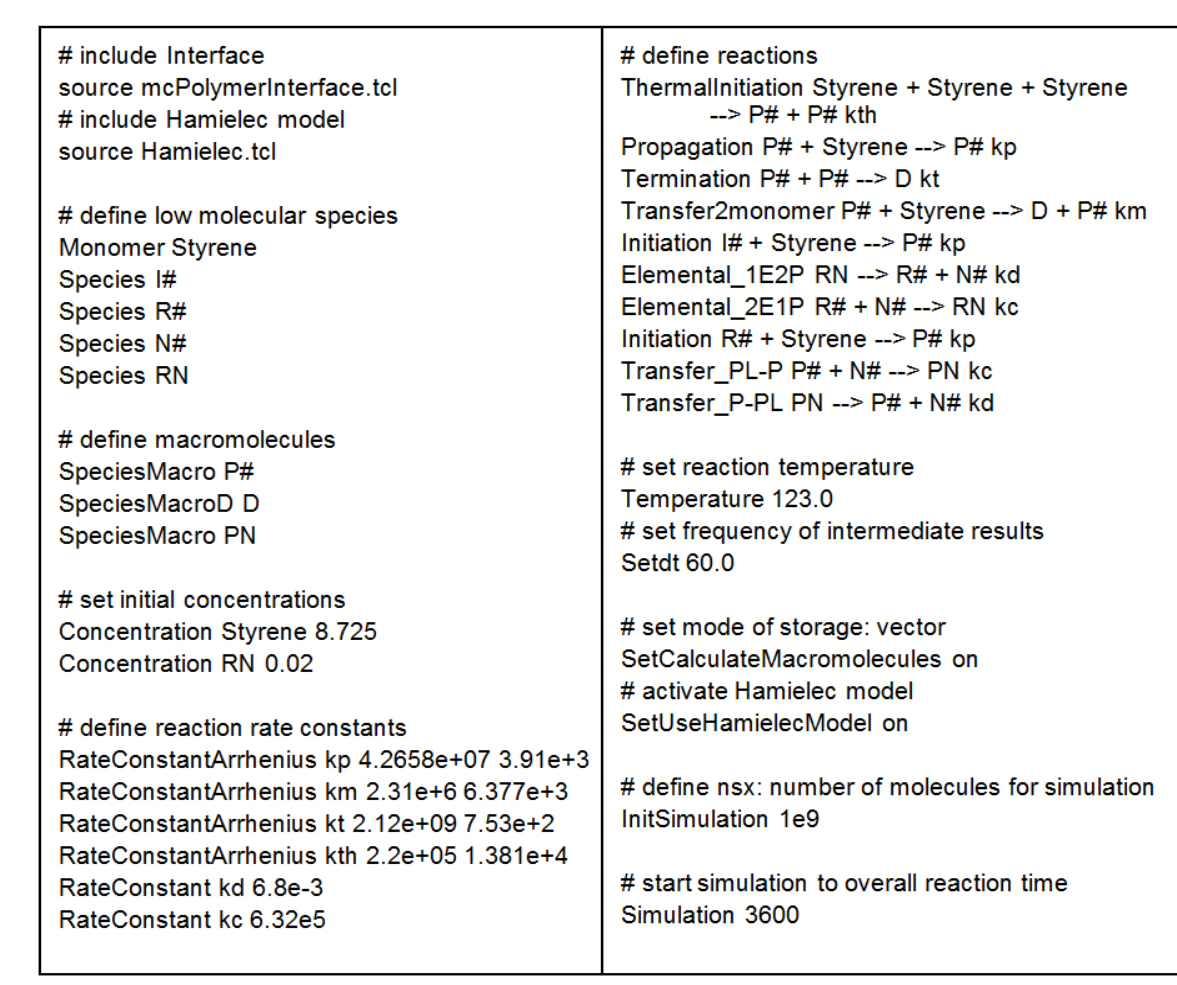
Figure 4. TCL scheme of an exemplary mcPolymer